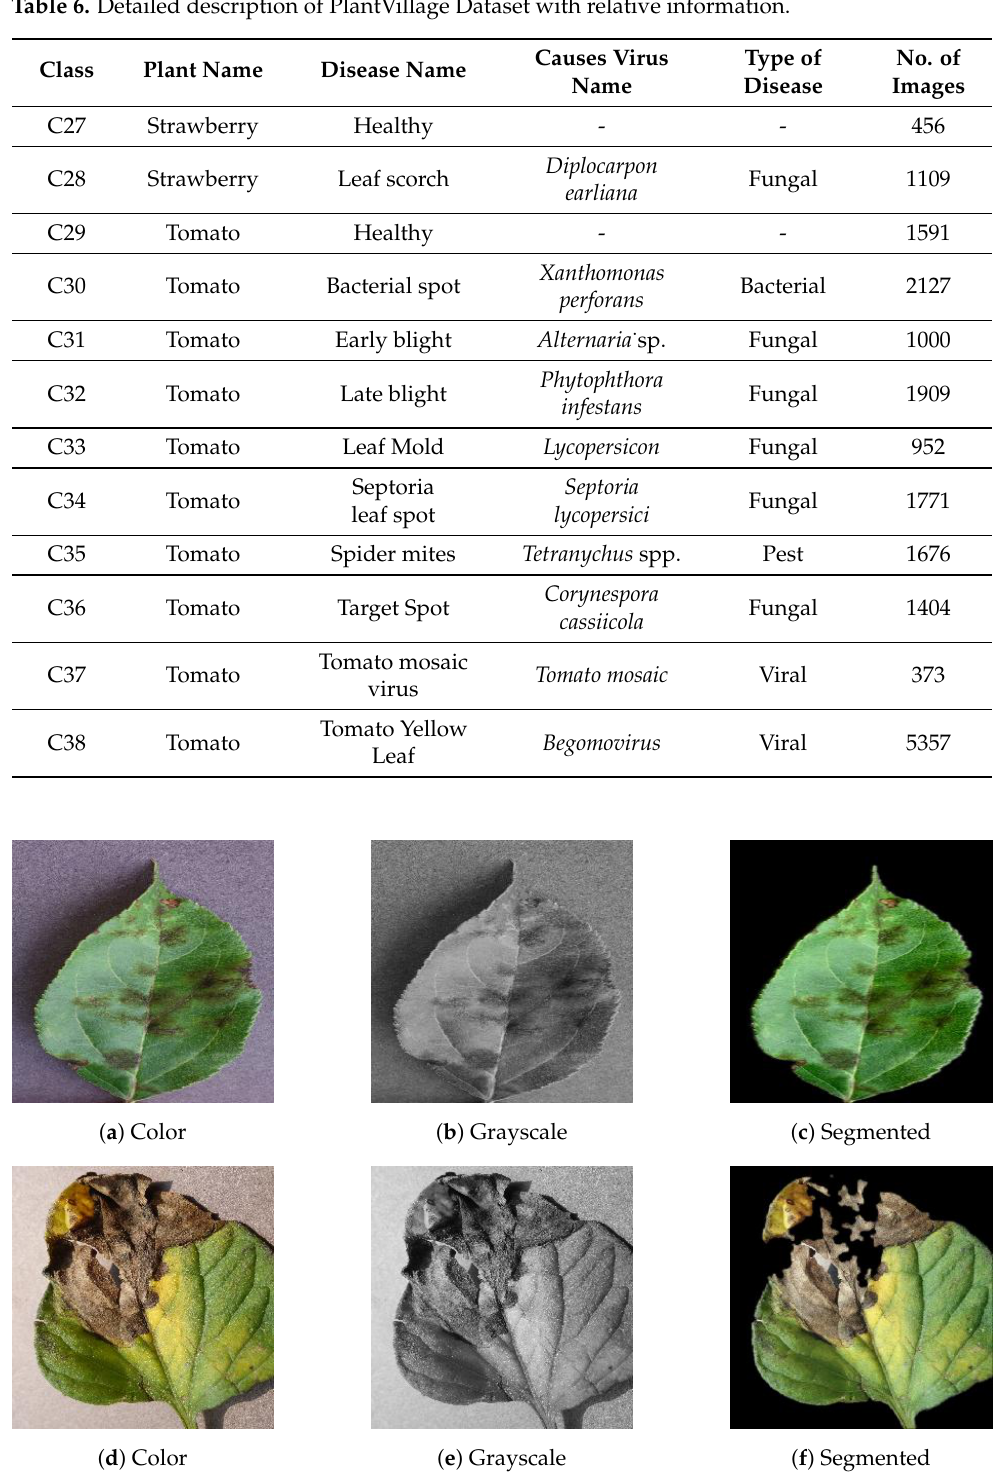
Figure 6. Sample images of color, grayscale and segmented version of PlantVillage image